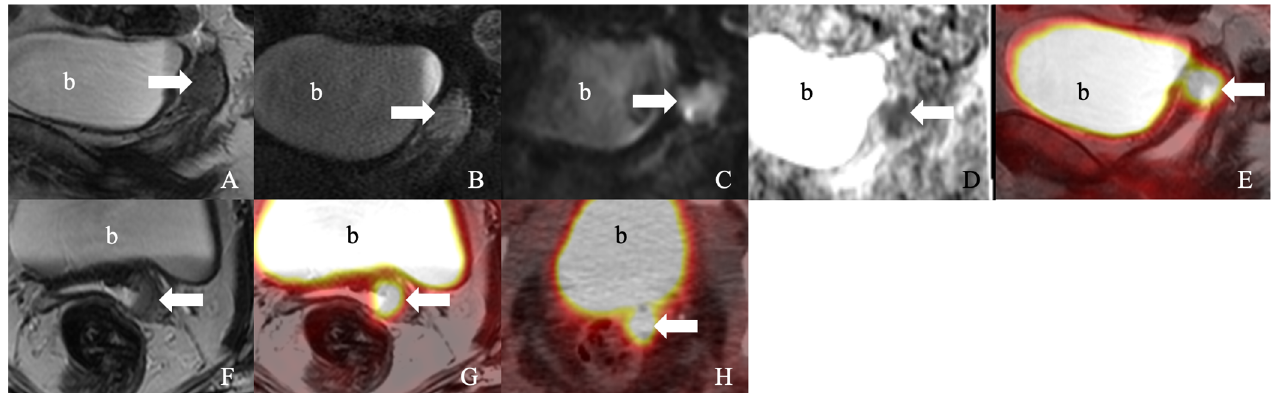
Figure 2. A 55-year-old woman with squamous cell carcinoma of the cervix, status post hysterec- tomy. ( A ). Sagittal T2-weighted imaging (T2WI), ( B ). post-contrast sagittal T1-weighted imaging (T1WI), ( C ). coronal diffusion-weighted image (DWI), ( D ). coronal apparent diffusion coefficient (ADC), ( E ). coronal fused T2WI, and ( F ). axial T2WI. ( G ). Axial fused T2WI positron emission tomography/MRI showed an enhancing (18)F-fluorodeoxyglucose (FDG) avid plaque-like thickening at the left cervix (arrow) with restricted diffusion. ( H ). An axial positron emission tomography/computed tomography image showed ill-defined FDG avidity (arrow). b: urinary bladder.